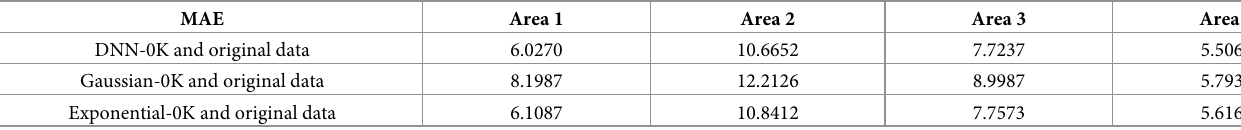
Table 4. MAE between the interpolation results and the original data in the four areas. MAE Area 1